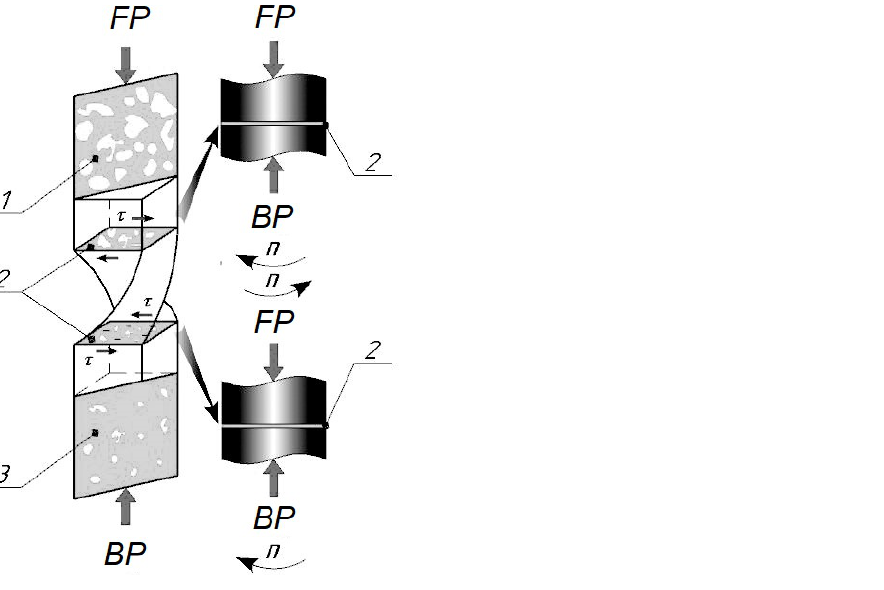
Figure 1. Deformation of a porous billet by twist extrusion: 1—before TE; 2—deformation zone; 3—after TE, FP —forward pressure, BP —back